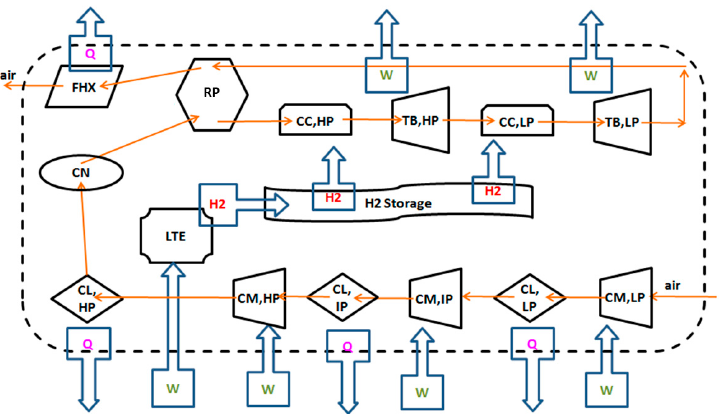
Figure 6. Schematic of the CAES-LTE system simulated. LTE stands for low temperature electrolyzer. “Q” and “W” represent heat and work interactions between the system and the surroundings. The air leaving the cavern is preheated in the recuperator by the hot air leaving the low pressure turbine (internal heat transfer).